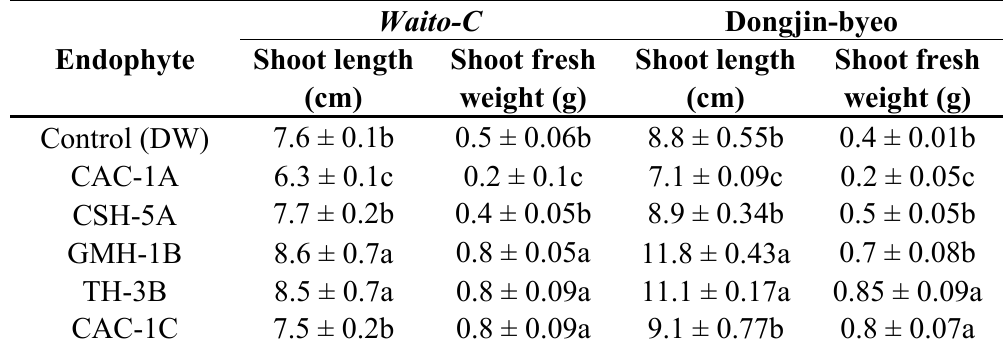
Table 1. Effect of culture filtrate of isolated endophytes on the growth of rice seedlings. Endophyte